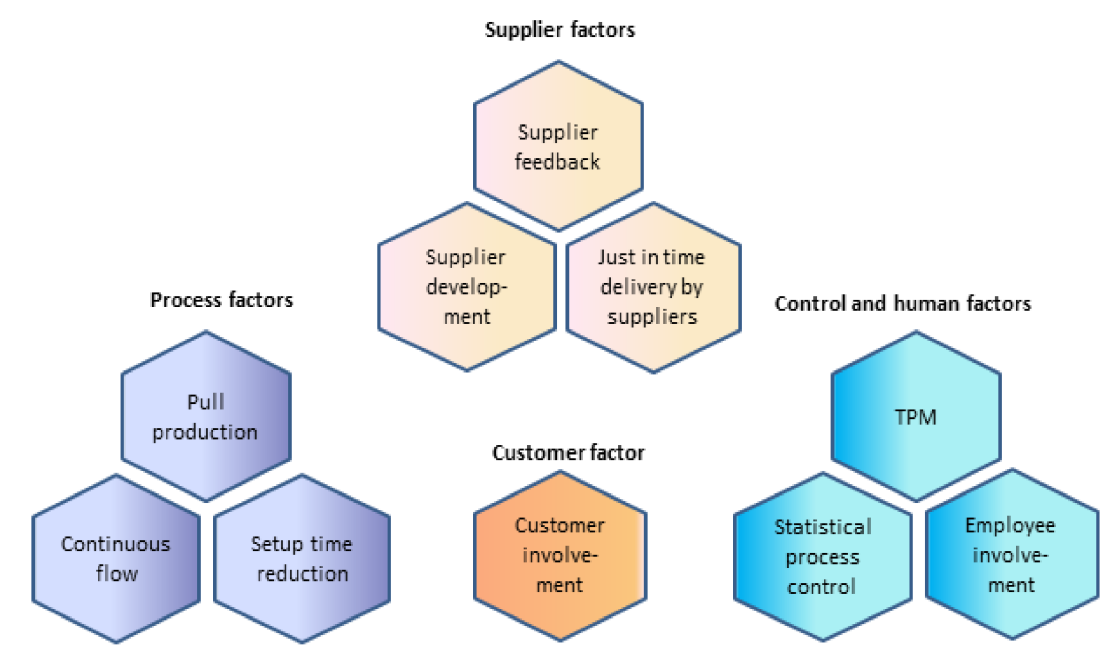
Figure 2. Grouped dimensions of lean